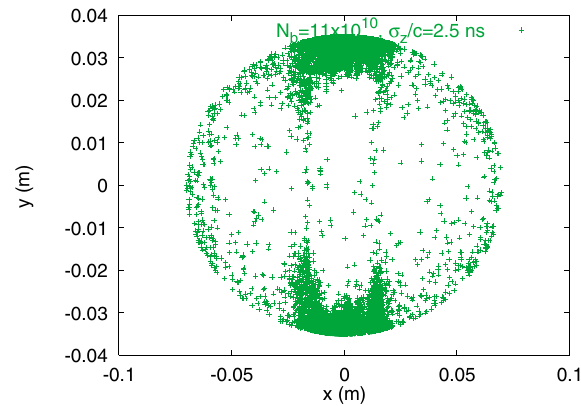
FIG. 7. (Color) Transverse electron distribution in a PS com- (cid:1) 11 (cid:2) 10 10 p = b and (cid:17) =c (cid:1) bined function magnet for N b z 2 : 5 ns , after about 1 (cid:16) s (passage of 40